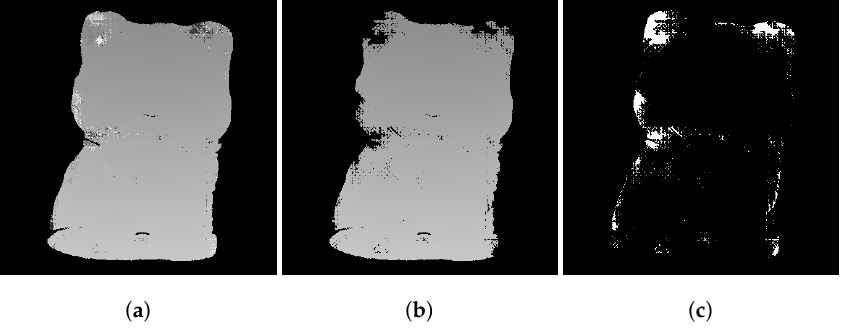
Figure 3. Example of determining the pixels to perform local spatial phase unwrapping on. ( a ) Φ 1 . ( b ) Φ 2 . ( c ) Pixels (white) that will be unwrapped by local spatial phase